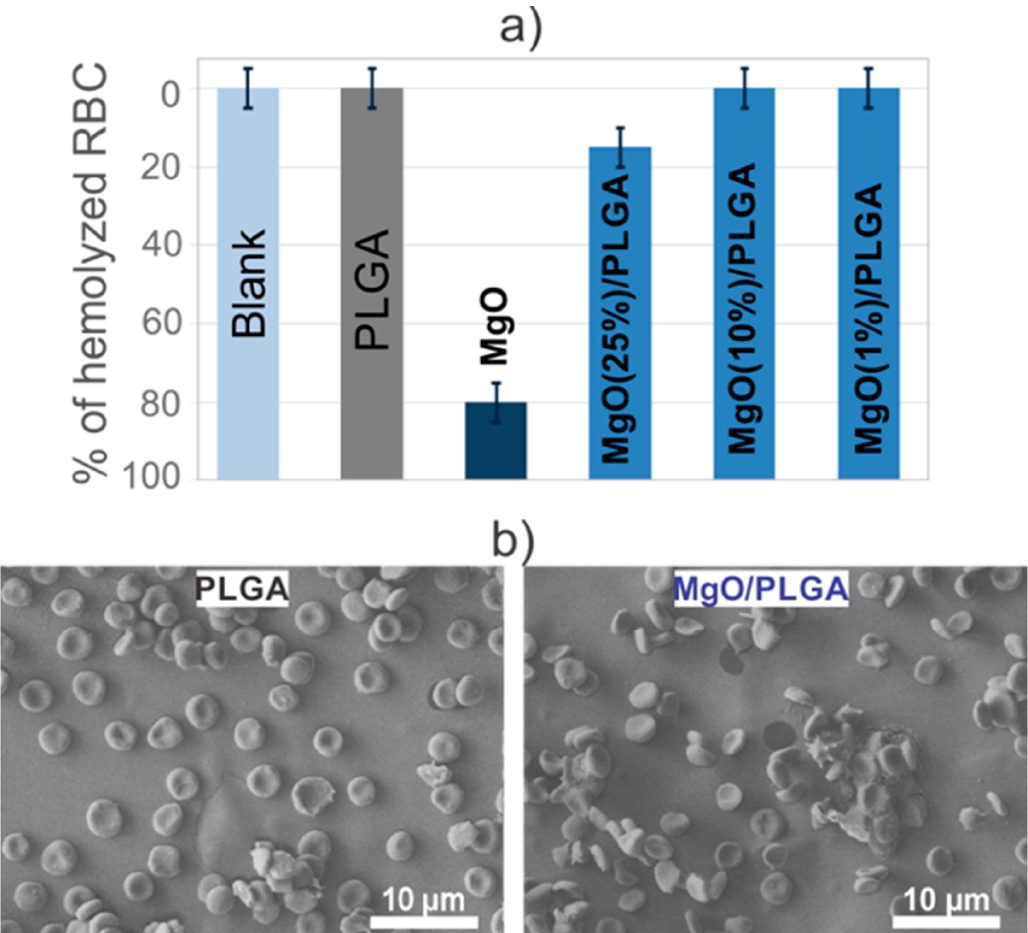
Figure 7. ( a ) Fraction of hemolysed red blood cells upon exposure to either MgO nanotextured MRs or MgO/PLGA coatings with different percentage of MgO content. Blank sample consists of only RBCs without any material. ( b ) Morphology of attached red blood cells on the PLGA and MgO/PLGA 0.10 coatings.